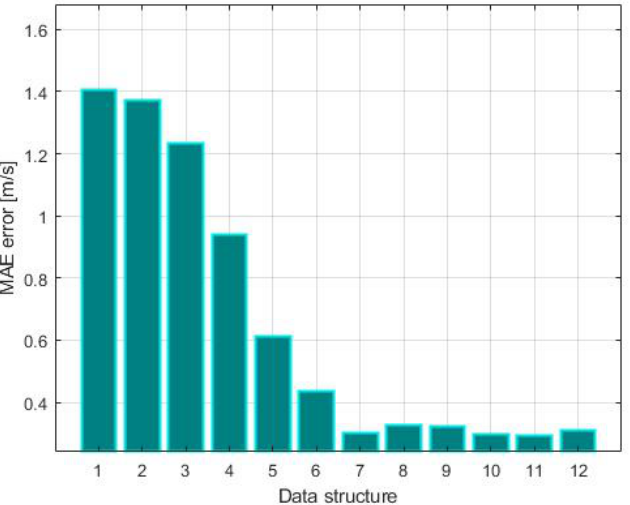
Figure 31. Comparison of data structures for wind power plant FW4, MAE